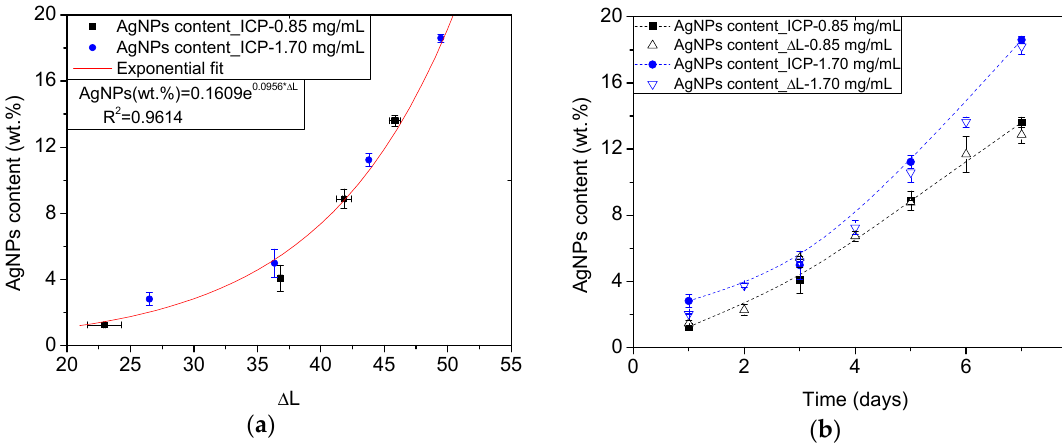
Figure 5. Calibration curve relating the AgNPs content (wt.%) reference values obtained by ICP-OES [10] and the Δ L* measured on the ME/Ag foams. The obtained calibration equation is shown in an inset ( a ). AgNPs content (wt.%) of all ME/Ag foams calculated from the measured Δ L* and using the previous calibration. Trends of the reference values from ICP-OES measurements are shown in dotted lines for comparison purposes ( b ).